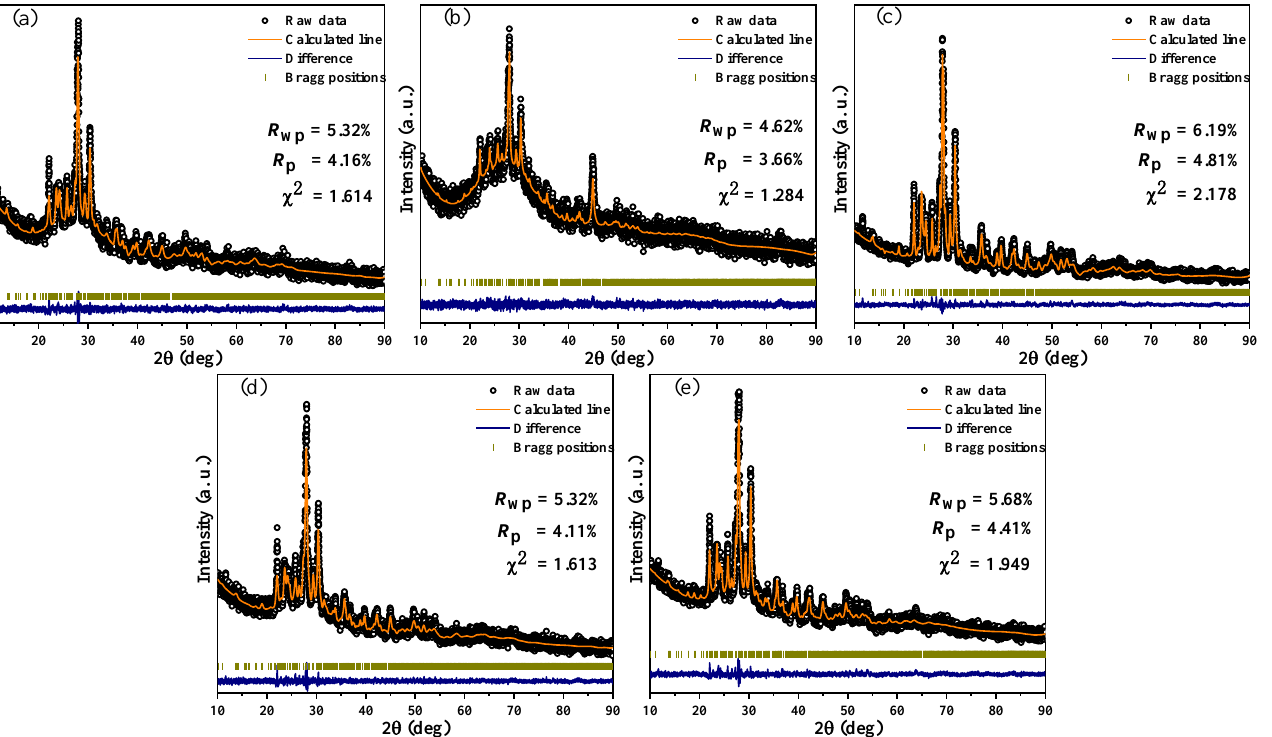
Figure 3. XRD refinement patterns of glass-ceramics with different Fe 2 O 3 contents: ( a ) 0 wt% Fe 2 O 3 ; ( b ) 3.11 wt% Fe 2 O 3 ; ( c ) 6.21 wt% Fe 2 O 3 ; ( d ) 9.32 wt% Fe 2 O 3 ; ( e ) 12.42 wt% Fe 2 O 3 .